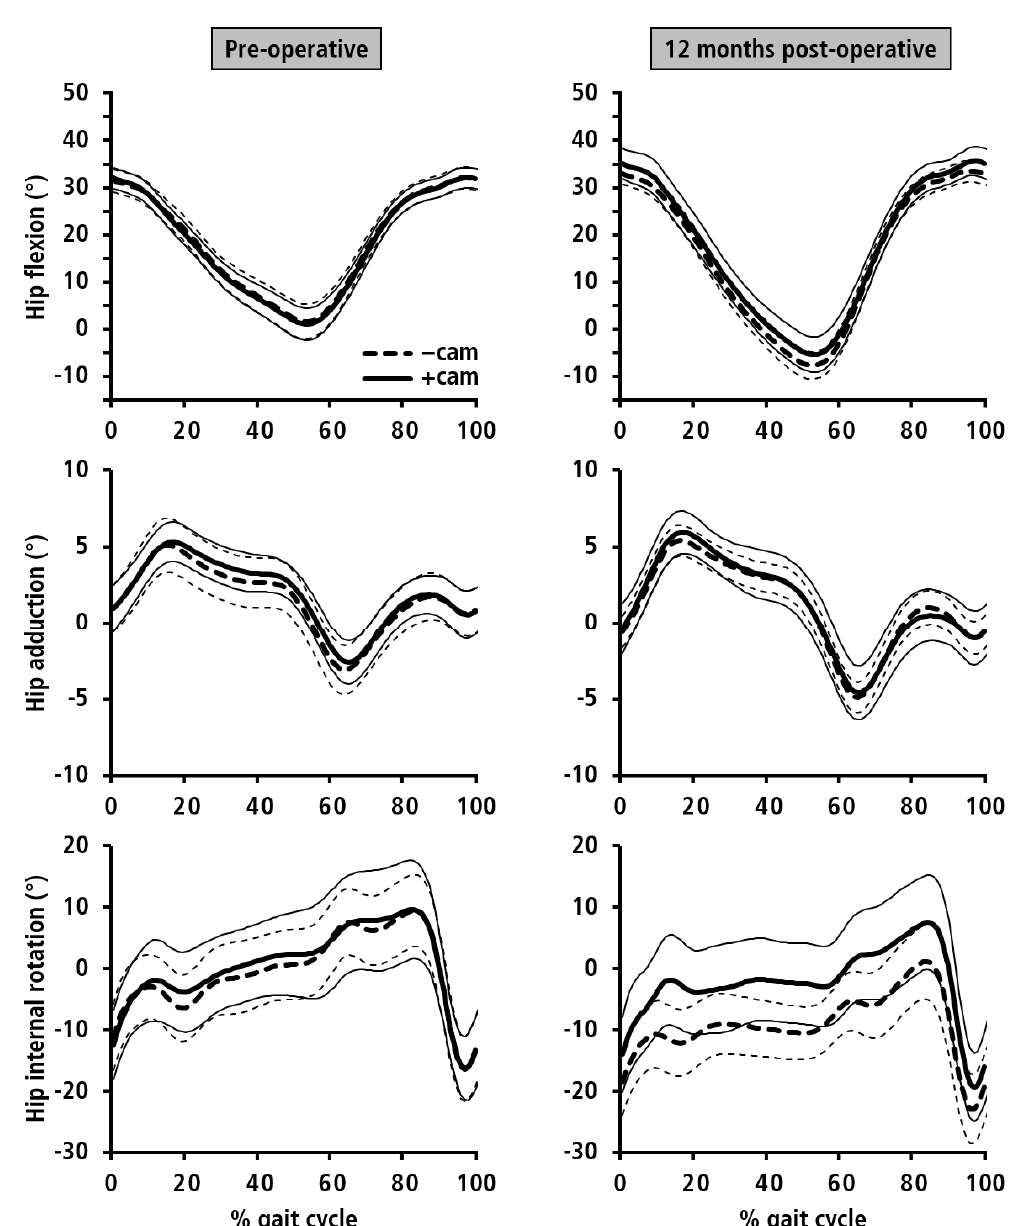
Figure 1. Mean value graphs (bold lines) with standard deviation (fine lines) of the gait cycles (0–100%) for both patient groups with (+cam) or without ( − cam) an FAI type cam before surgery and at the last follow-up. The analysis was based on the values at 0% (heel strike) and 60% (toe off).